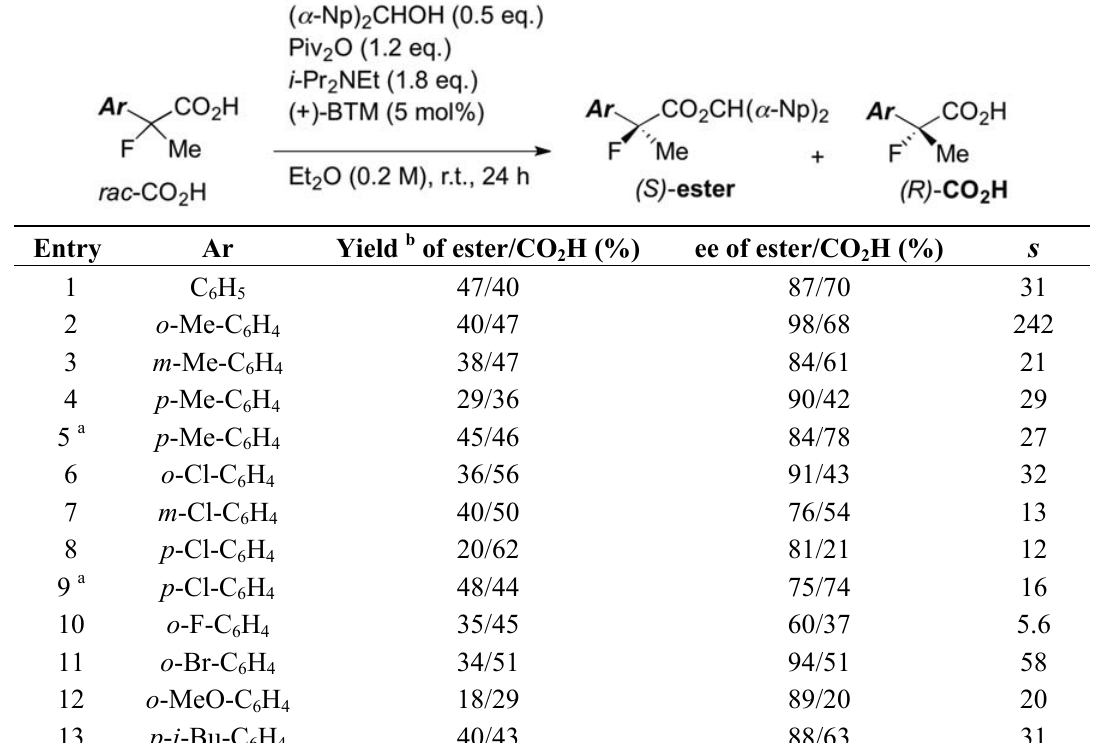
Table 2. Kinetic resolution of 2-aryl-2-fluoropropanoic acids using (+)-BTM.